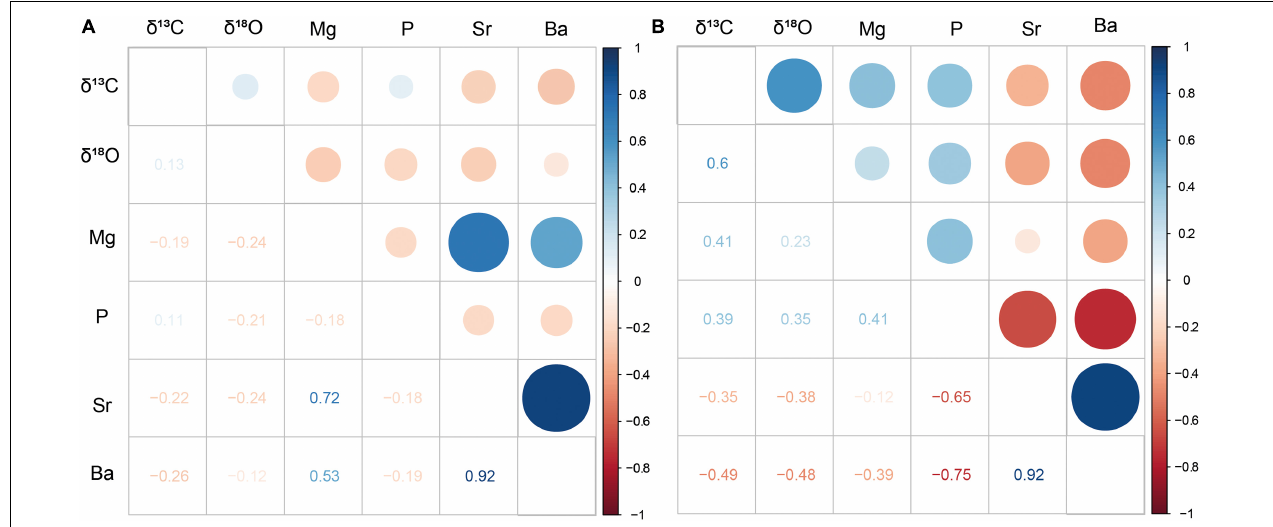
FIGURE 8 | Correlation matrix of centennial means for stable carbon and oxygen isotopes and trace elements of stalagmite HBSH-3 during the early (A) and late (B) phase of the Holocene. The size of the circles increases with increasing positive/negative correlation.